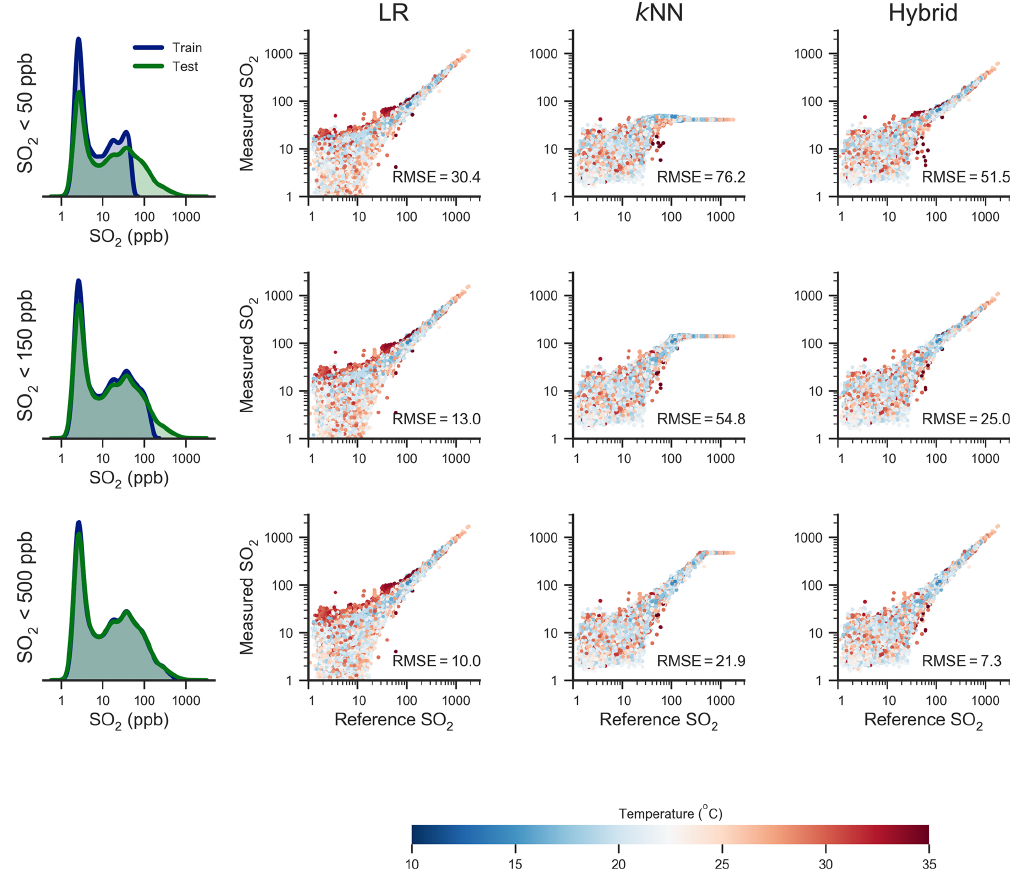
Figure 6. Comparing linear regression, k nearest neighbors regression, and hybrid regression on various subsets of the training data by splitting on arbitrary SO 2 thresholds (row 1: < 50ppb; row 2: < 150ppb; row 3: < 500ppb). All models were validated using the entire SO 2 and T ranges of the previously withheld validation